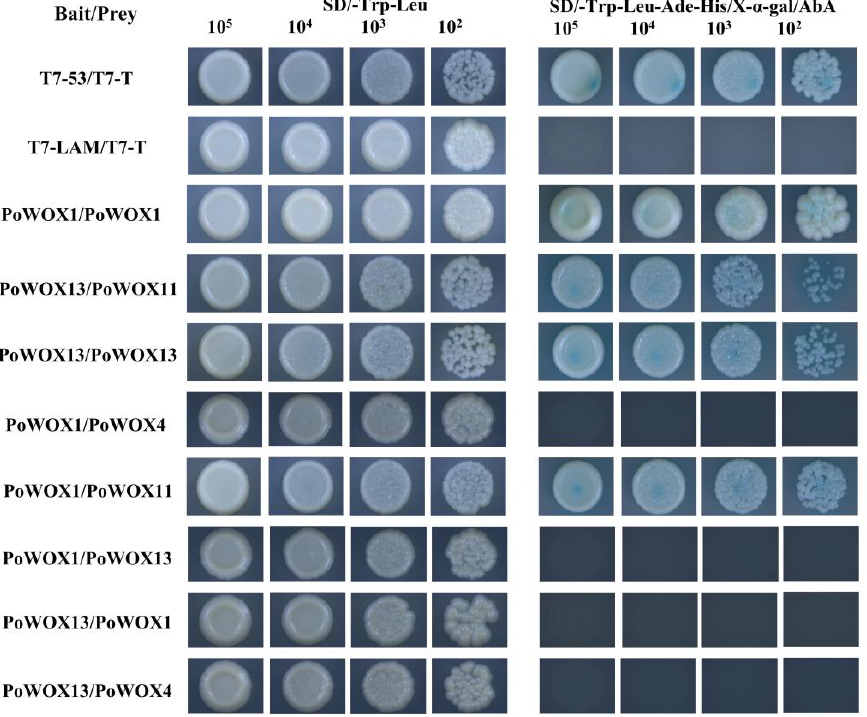
Figure 8. Protein interactions analysis between PoWOX members in yeast two-hybrid assay. The CDS sequences of PoWOX1, PoWOX4, PoWOX11, and PoWOX13 were cloned into pGBKT7 (bait) vector and pGADT7 (prey) vector, respectively. Co-transformation to SD/-Trp-Leu plates and SD/- Trp-Leu-Ade-His/X- α -gal/AbA plates was performed to verify the interactions between PoWOX members. pGBKT7-53/pGADT7-T (T7-53/T7-T) was co-transformed as a positive control and pGBKT7-LAM/pGADT7-T (T7-LAM/T7-T) was co-transformed as a negative control. The pictures were taken by Zeiss Stemi 305 microscope to preserve.